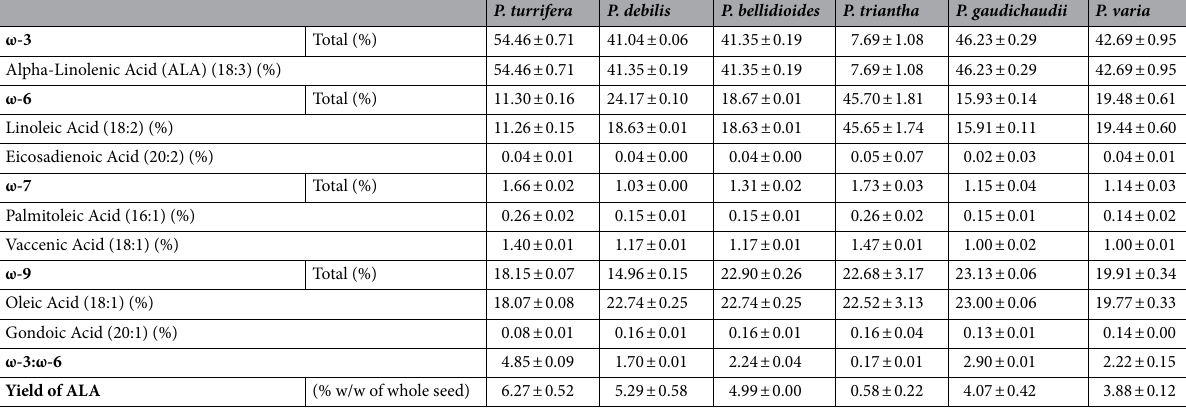
Table 1. Summary of morphometric and nutritional characteristics of seeds of 12 Plantago species. Values are means and standard